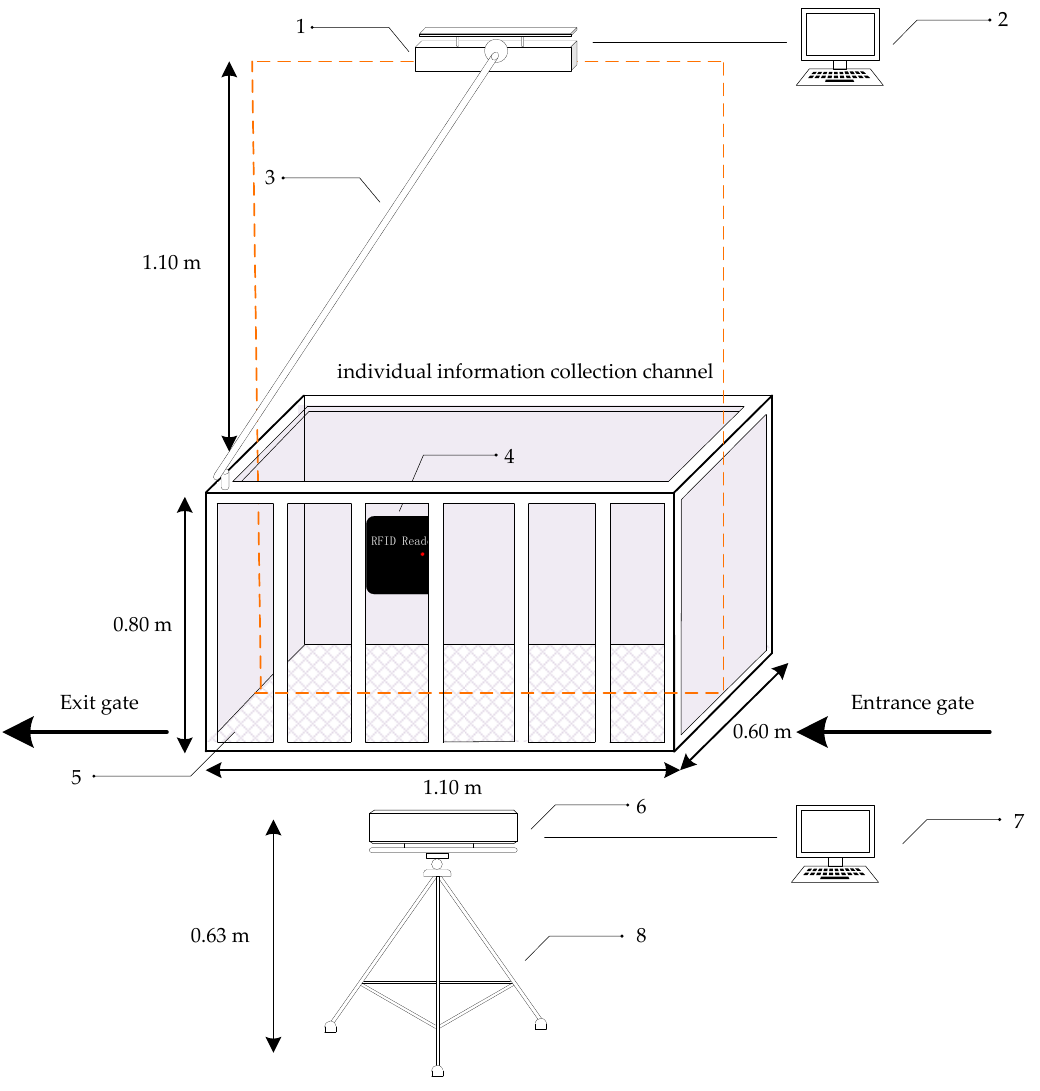
Figure 1. Data acquisition platform constructed in the information collection channel: 1 – top-view Kinect; 2 – computer connected to the top-view Kinect; 3 – rocker; 4 – RFID reader; 5 – weight scale; 6 – side-view Kinect; 7 – computer connected to the side-view Kinect; 8 – tripod.